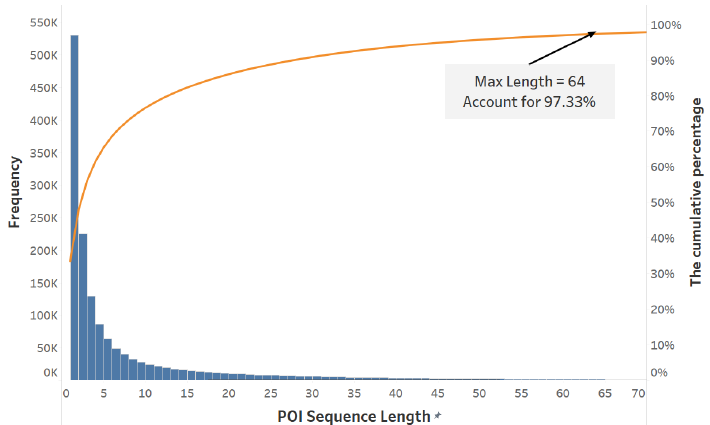
Figure 3. Distribution of POI sequence length of grids. The POI sequence length is the number of POIs in a level-7 Geohash grid. The max length is set to 64, which covers